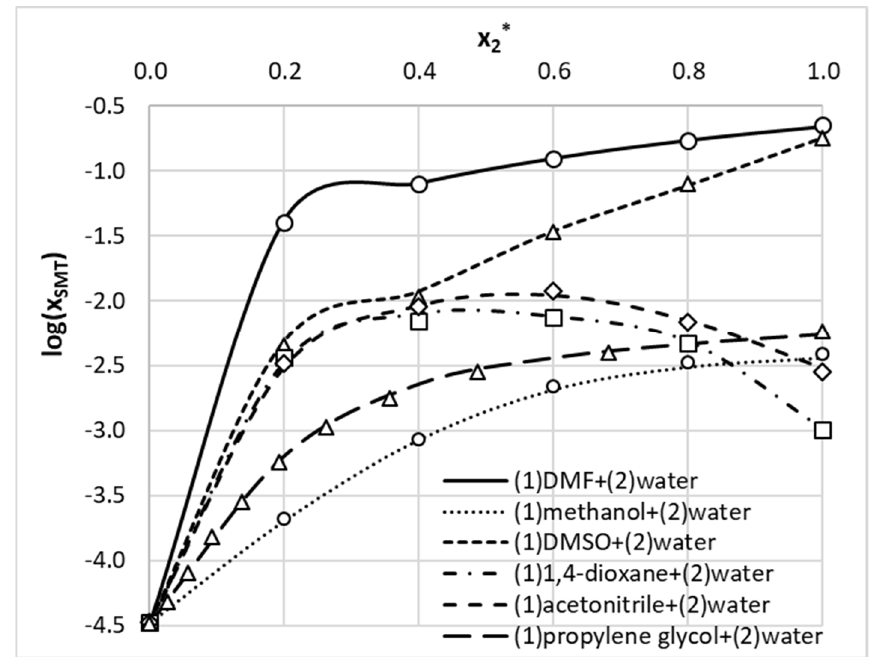
Figure 7. Accuracy of sulfamethizole solubility prediction using the developed ensemble of SANNs applied for five studied binary systems at room temperature. Open symbols represent measured data; the lines stand for predicted trends. x 2 * represents the mole fraction of an organic solvent in solute-free binary solution.